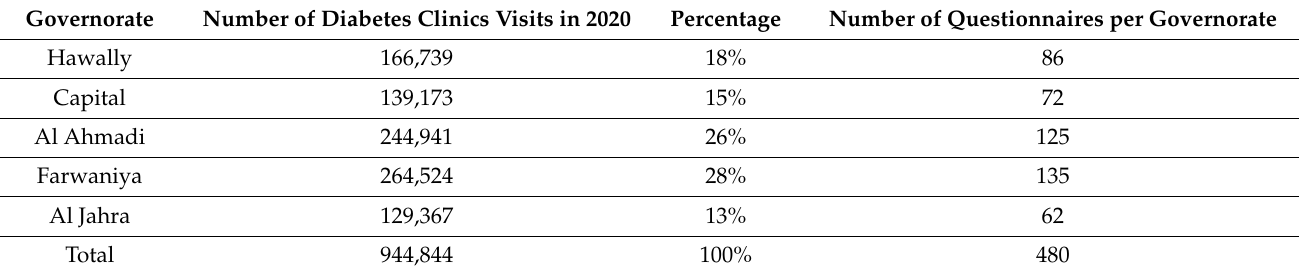
Table 1. Questionnaire distribution plan across the governates,